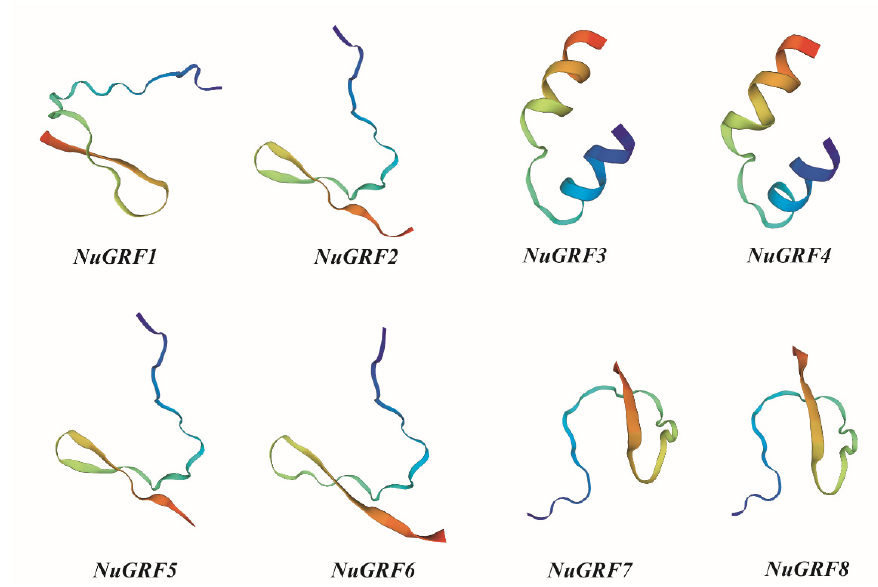
Figure 8. The 3D structure modeling of NuGRF proteins. The tertiary structures were colored by rainbow order, representing N to C terminus.